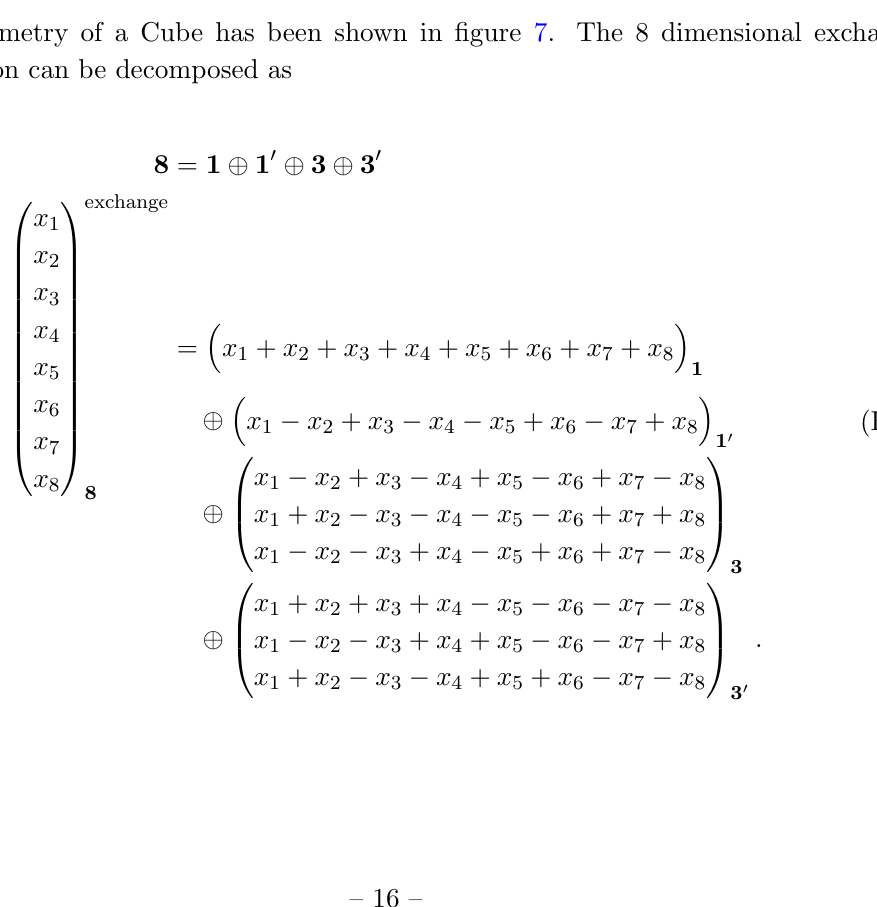
4 , the group of all possible x 1 ; x 7 x 7 ; x 2 x 4 x 5 x 2 ; x 3 x 8 7! 7! 7! 7! 7! 7!